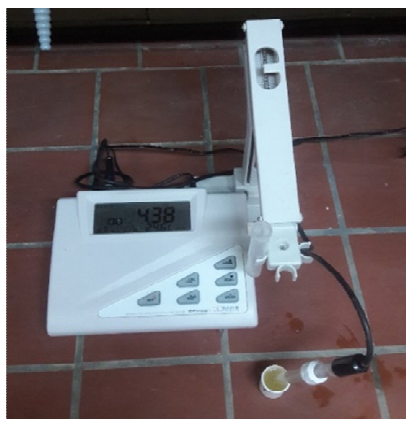
Figure 3. pH meter. Figure 3. pH